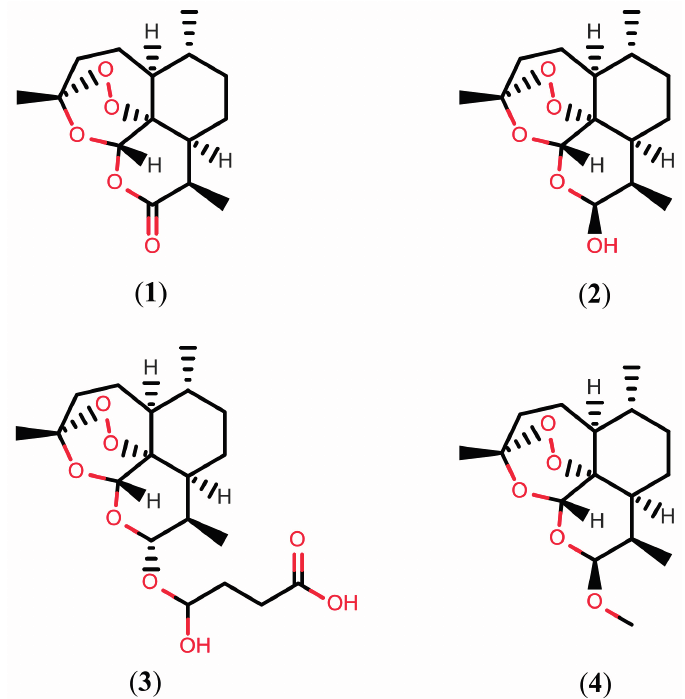
Figure 1. Chemical structures of